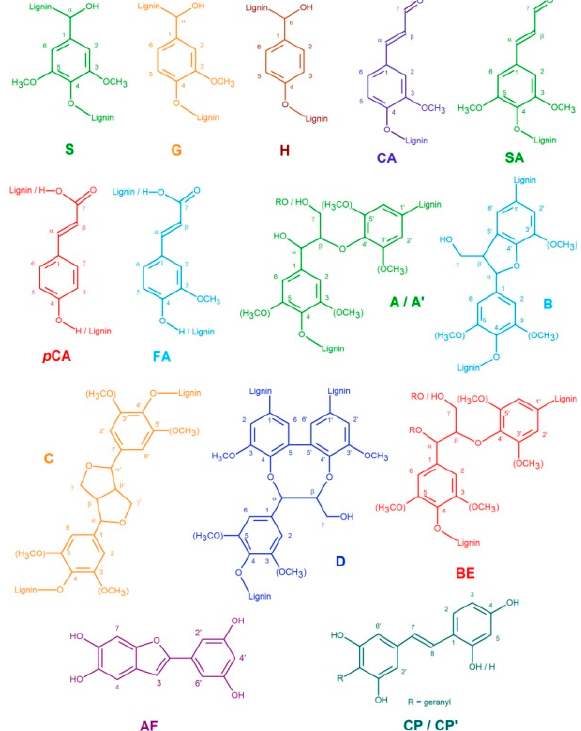
Figure 4. Lignin structural elements assigned to the respective cross-peaks in the 2D NMR spectra: syringyl (S), guaiacyl (G), p -hydroxyphenyl (H), coniferyl aldehyde (CA), sinapyl aldehyde (SA), p -coumaric acid ( p CA), ferulic acid (FA), alfafuran (AF) and chlorophorin (CP, CP ′ ) units; β - O -4 ′ (A) and γ -acylated β - O -4 ′ (A ′ ) substructures, β -5 ′ phenylcoumaran (B), β - β′ resinol (C), dibenzodioxocin (D) and benzyl ether (BE) substructures.